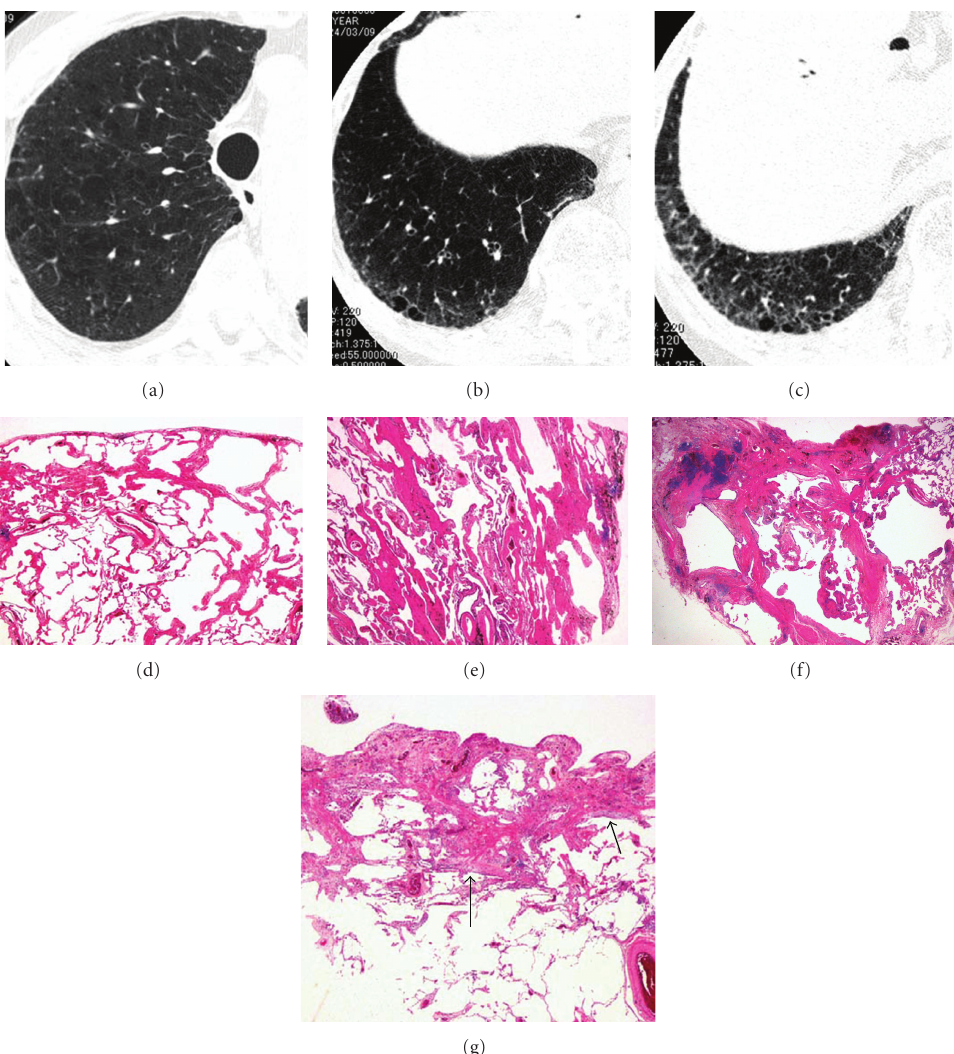
Figure 3: Di ff use interstitial pneumonia (UIP pattern), emphysema with fibrosis. The patient underwent right lower lobectomy for lung cancer of the right lower lobe. (a) HRCT of the right upper lobe shows severe centrilobular emphysema. (b) HRCT of the right lower lobe shows slight ground glass opacity including several thick-walled cyst. (c) HRCT of basilar region shows subpleural ground glass opacity and reticular opacity in the subpleural region: radiologically consistent with UIP pattern. There are some relatively thick-walled cysts in subpleural region; however, no evidence of honeycombing. (d) Pathologic specimen (H&E staining) shows centrilobular and paraseptal emphysema with collagen type fibrosis. (e) Pathologic specimen shows dense centrilobular collagen-type fibrosis, associated with centrilobular emphysema. (f) Pathologic specimen shows cystic lesion in the acinus with destruction of alveoli and dense perilobular and peribronchiolar fibrosis. Normal alveoli adjacent to the cystic lesion. (g) Pathologic specimen shows patchy subpleural and intralobular fibrosis with alternating emphysematous, nonfibrotic area. Note fibroblastic foci (arrows). Sharp border between advanced fibrosis and normally appeared tissue suggests UIP